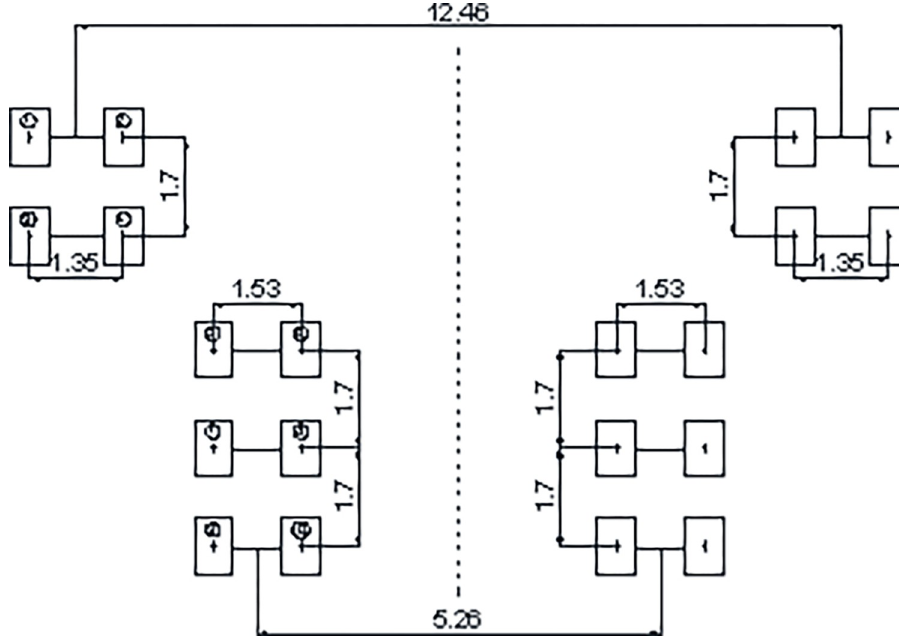
Fig 1. Configuration of the main landing gear of A380-800 (unit: